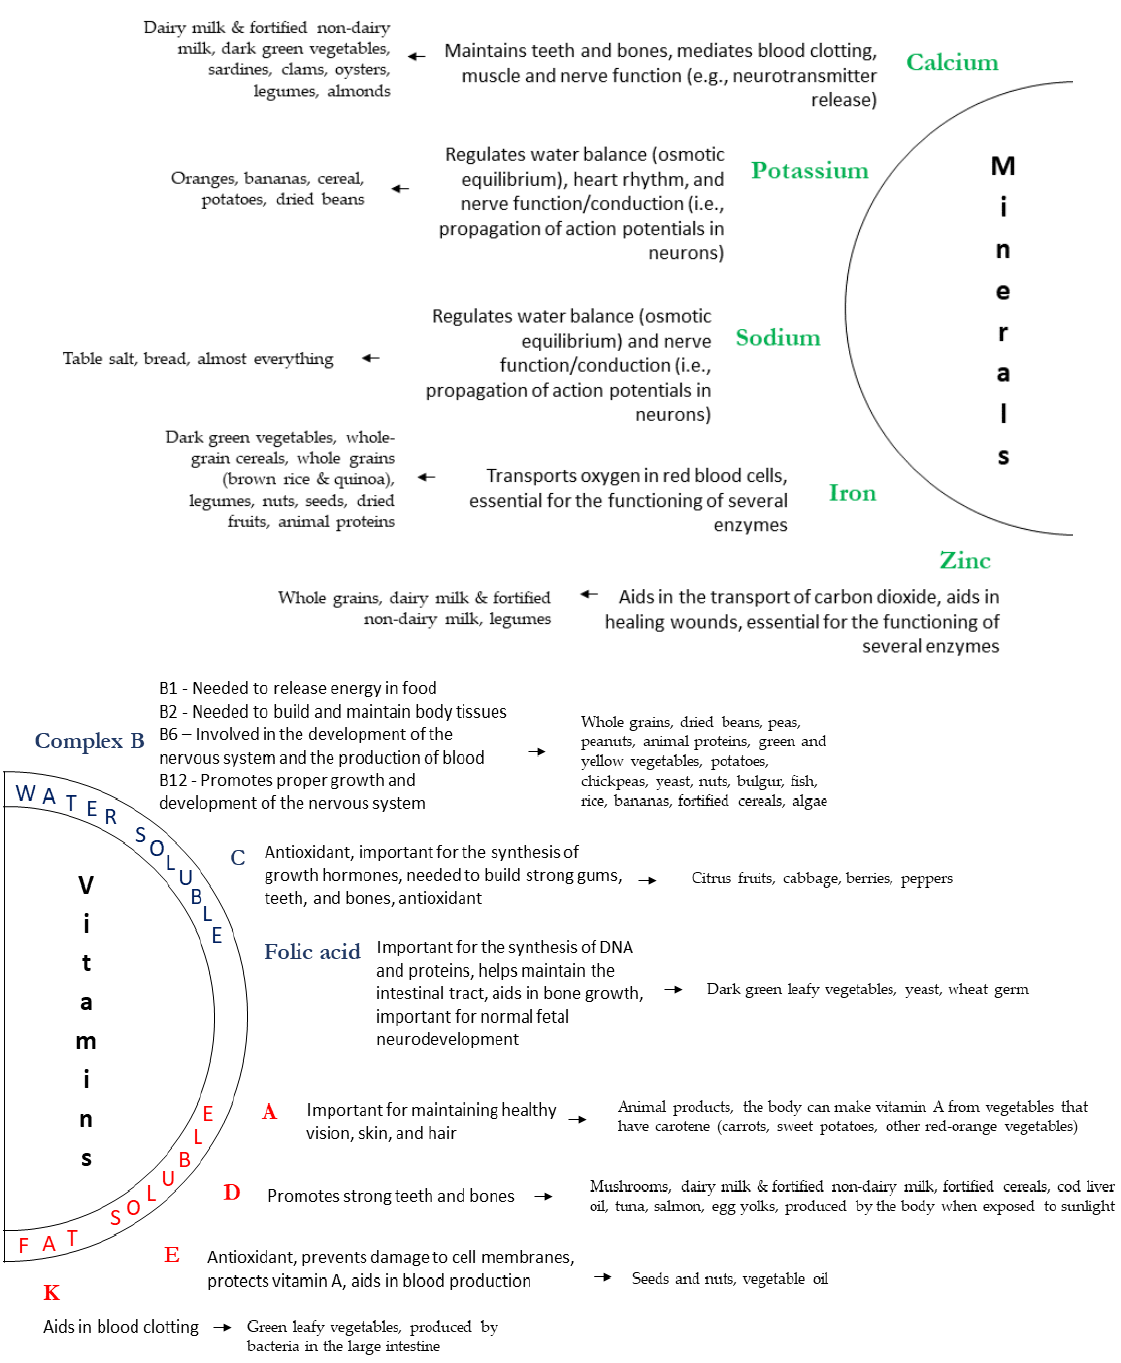
Figure 2. Main micronutrients and their sources and functions. Source: Author’s own work.